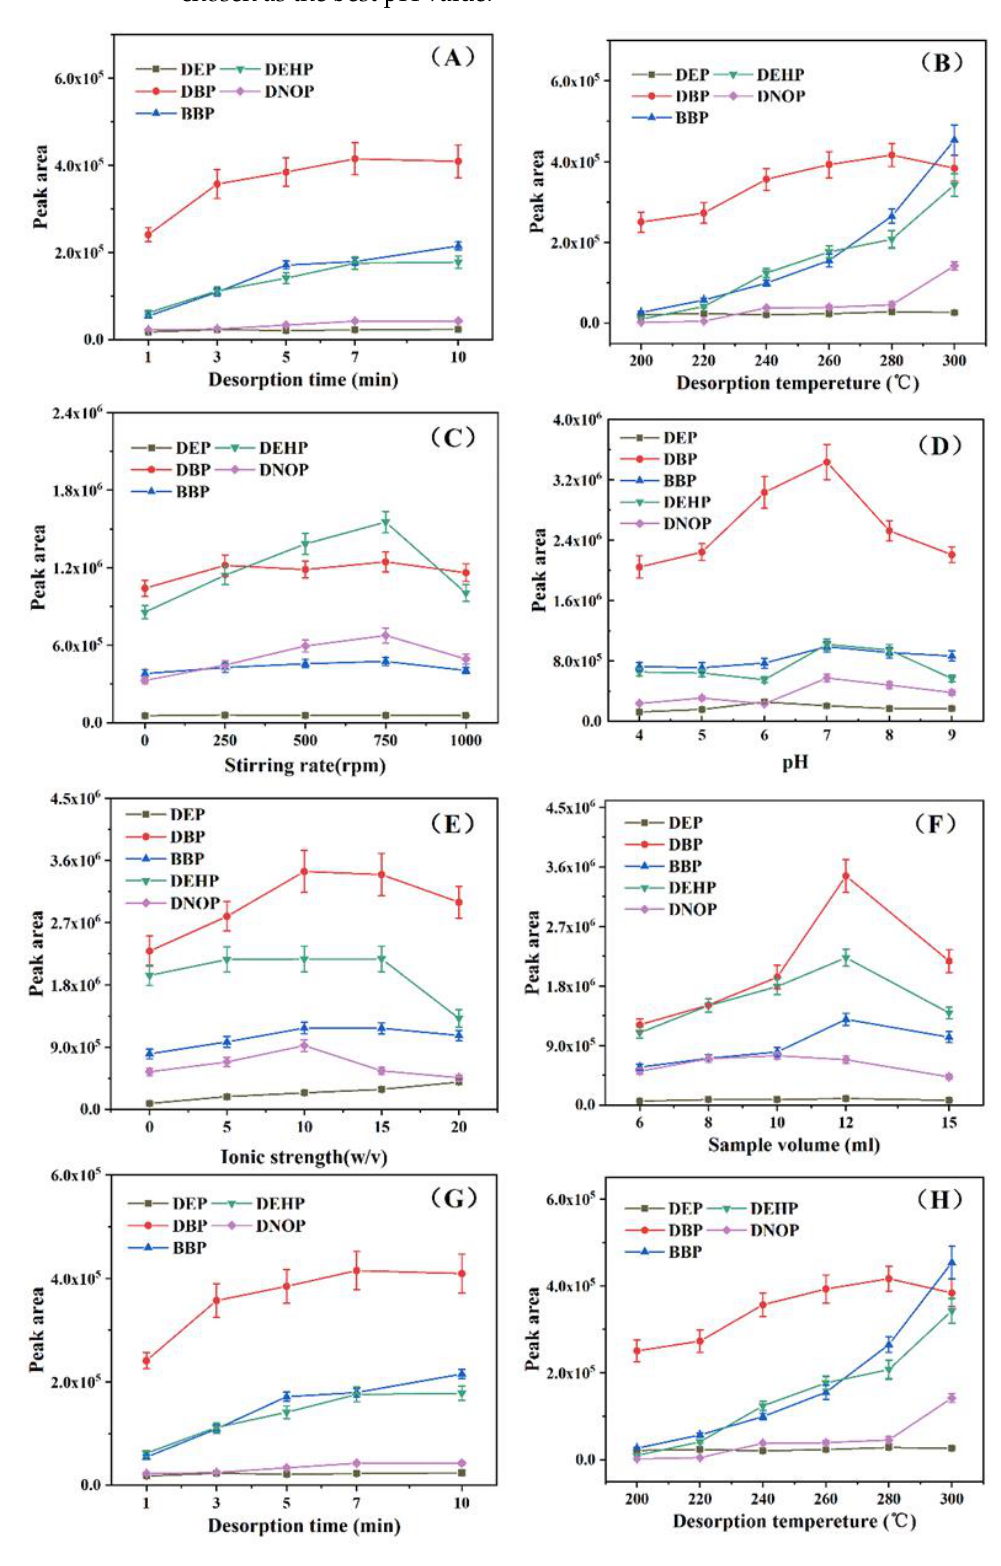
Figure 4. Effect of typical parameters on the peak areas of 100 μg L −1 five PAEs. ( A ) Extractant time; ( B ) Extractant temperature; ( C ) Stirring rate; ( D ) pH; ( E ) Ionic strength; ( F ) Sample volume; ( G ) Desorption time; ( H ) Desorption temperature.